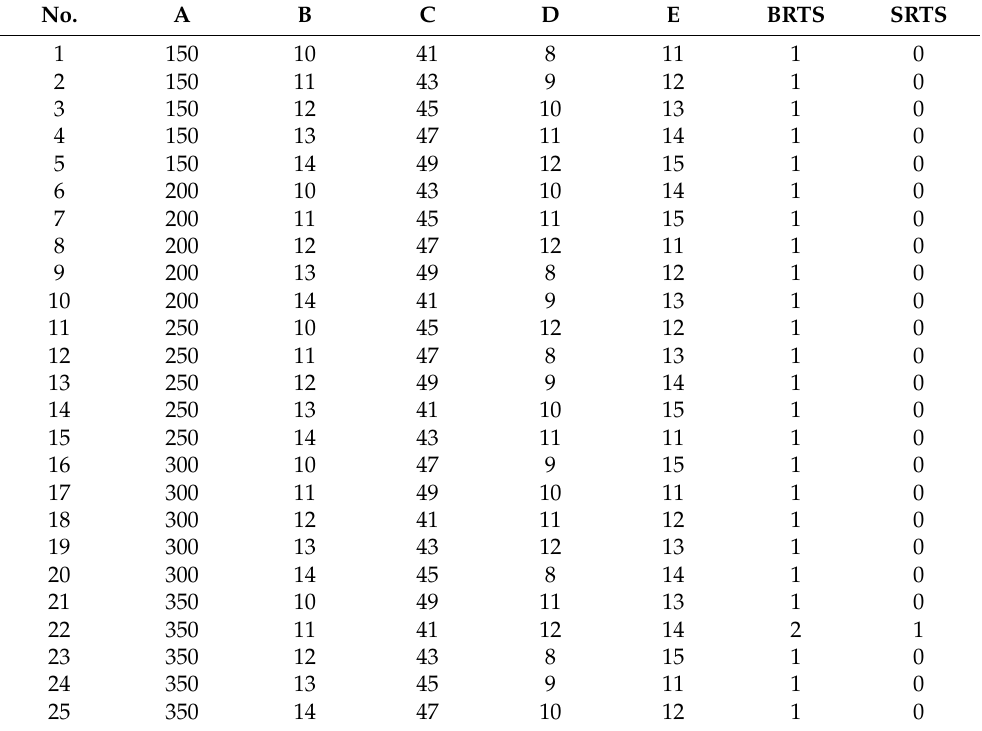
Table 7. Wire rupture times of both BWE and ZCSMWE.